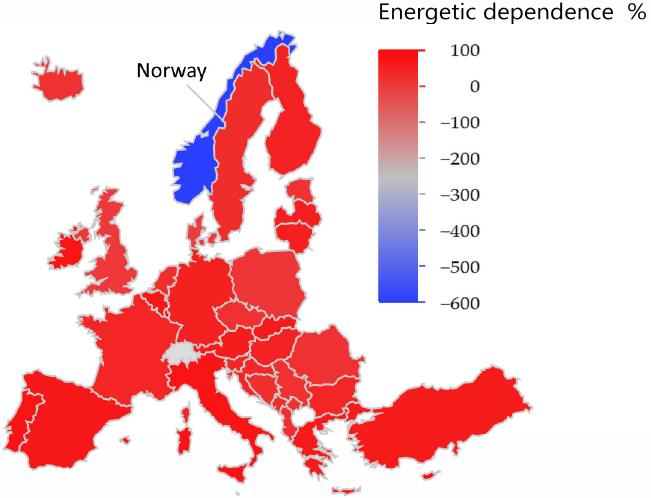
Figure 5. Cartographic representation of energy dependence for EU countries in average values in 1990–2006. Source: own processing according to [20], processing in JMP.